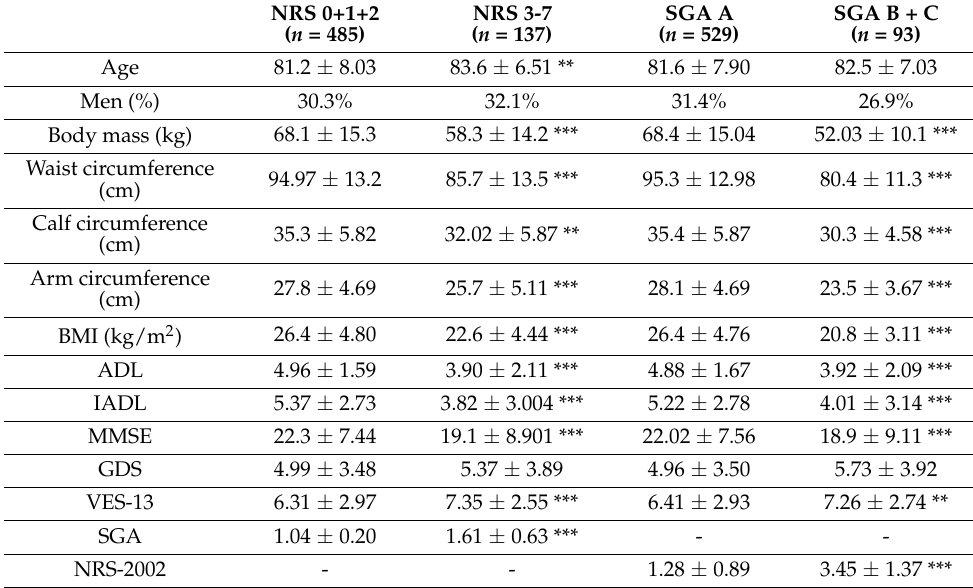
Table 5. Comparison of the subjects with different nutritional status according to NRS-2002